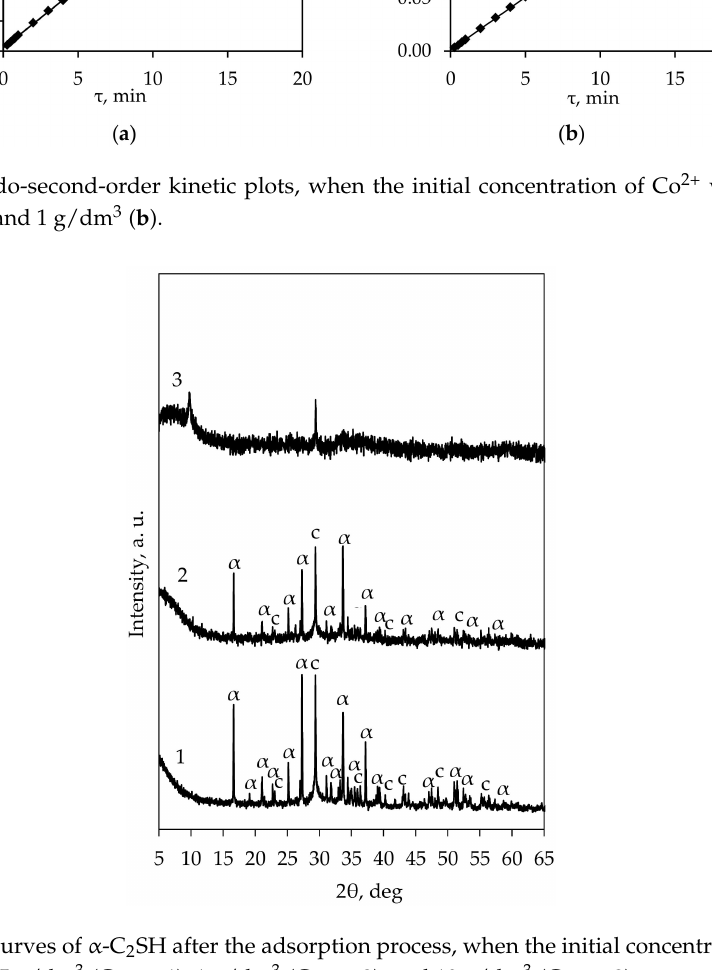
Figure 6. XRD curves of α -C 2 SH after the adsorption process, when the initial concentration of Co 2+ was equal to 0.25 g/dm 3 (Curve 1), 1 g/dm 3 (Curve 2), and 10 g/dm 3 (Curve